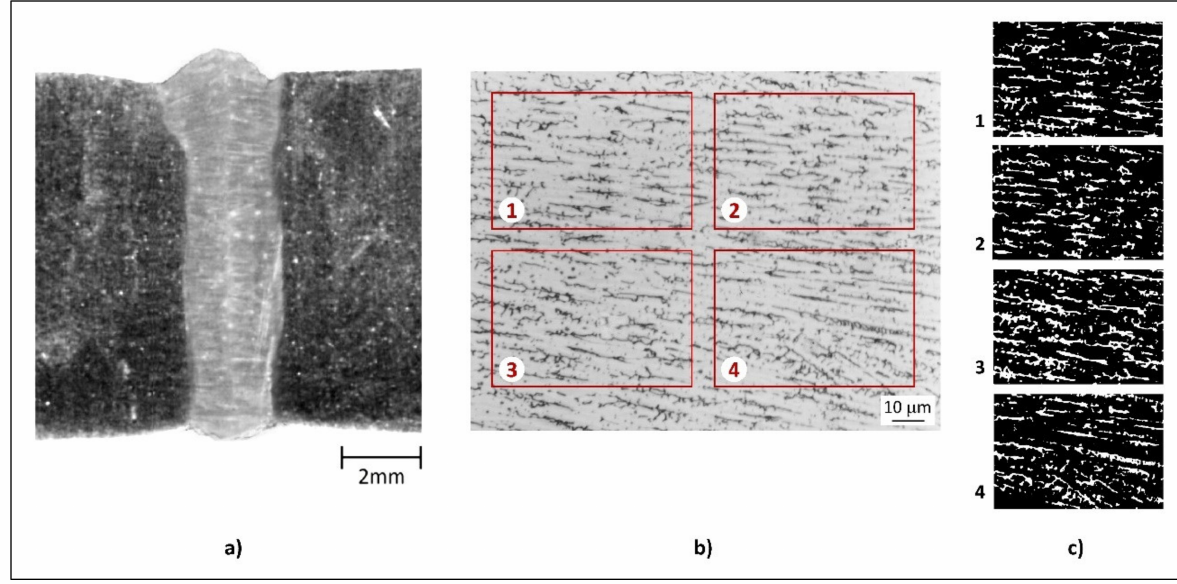
Figure 2. Properties of weld bead: ( a ) macrograph of the welded cross section (amplification power 1 × ); ( b ) detail of the fused zone (FZ) (amplification power 200 × ); ( c ) images elaborated for the determination of ferrite volume